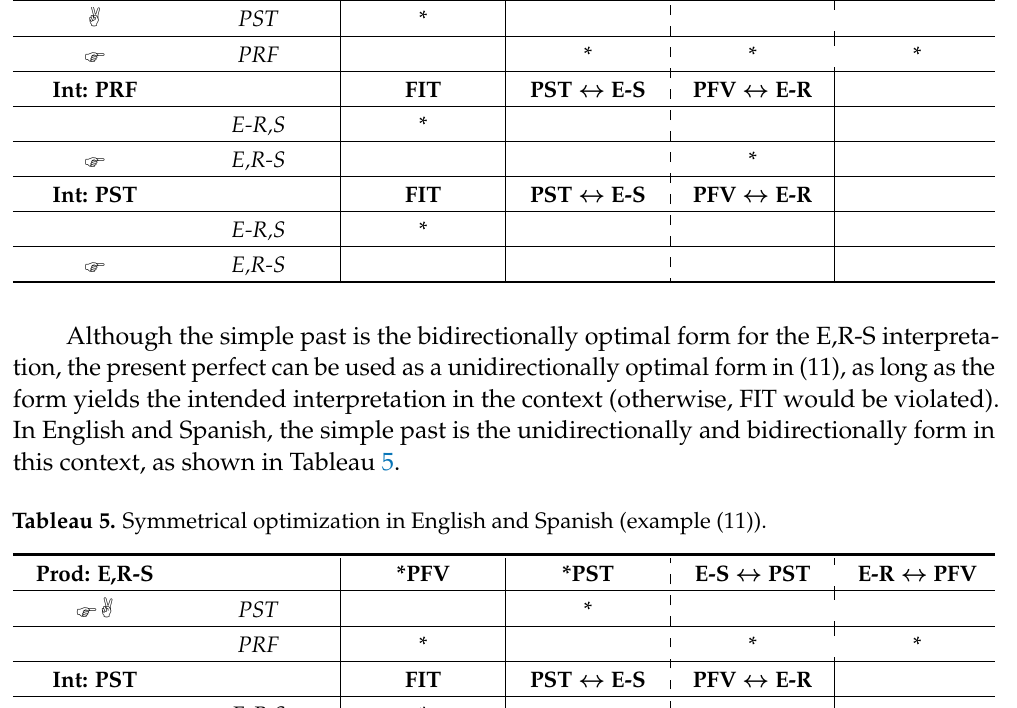
Tableau 2. Asymmetrical optimization in English and Spanish (example (12)).